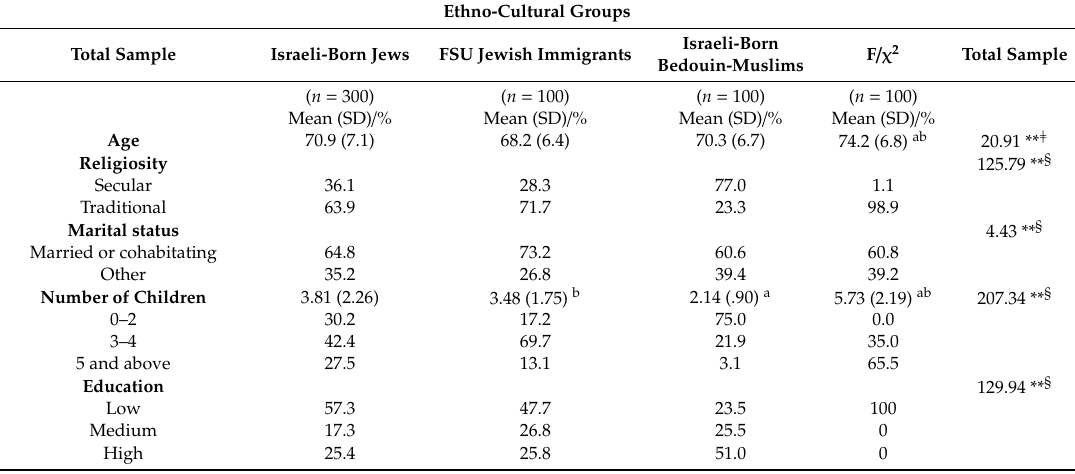
Table 1. Descriptive statistics of the study variables by ethnicity. FSU—Former Soviet